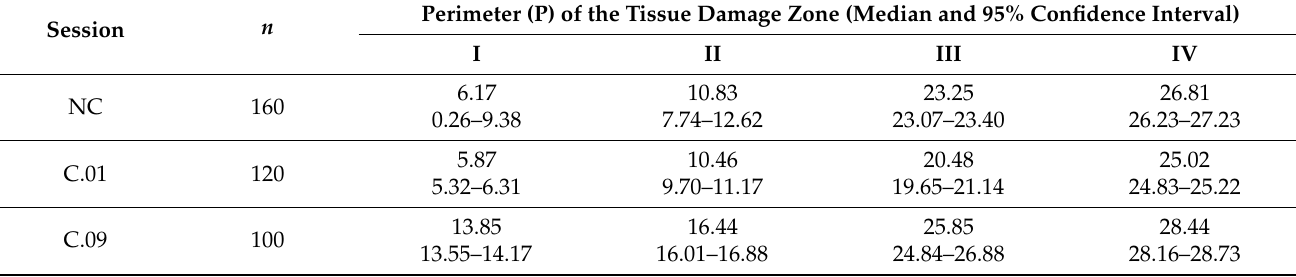
Table 3. Perimeters (P) of tissue damage zones, calculated as their medians and confidence intervals. Perimeter (P) of the Tissue Damage Zone (Median and 95% Confidence